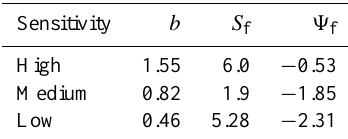
Table 1. Baseline parameter values used to represent the three sen- sitivities: “high” ( Quercus robur ), “medium” ( Quercus ilex ) and “low” ( Cedrus atlantica ) to drought stress. Parameter values are taken from Zhou et al. (2013,